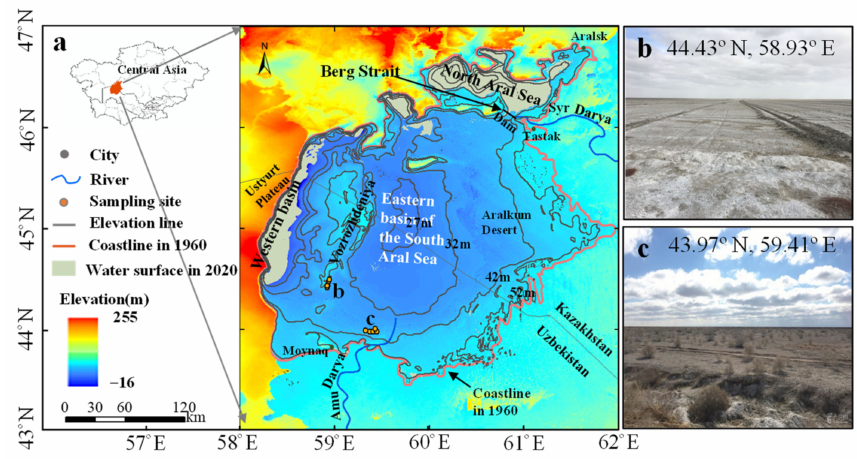
Figure 1. Location of the Aral Sea in Central Asia and its digital elevation model: ( a ) the location of the study area and soil sampling sites; ( b , c ) pictures of two of ten sampling sites.